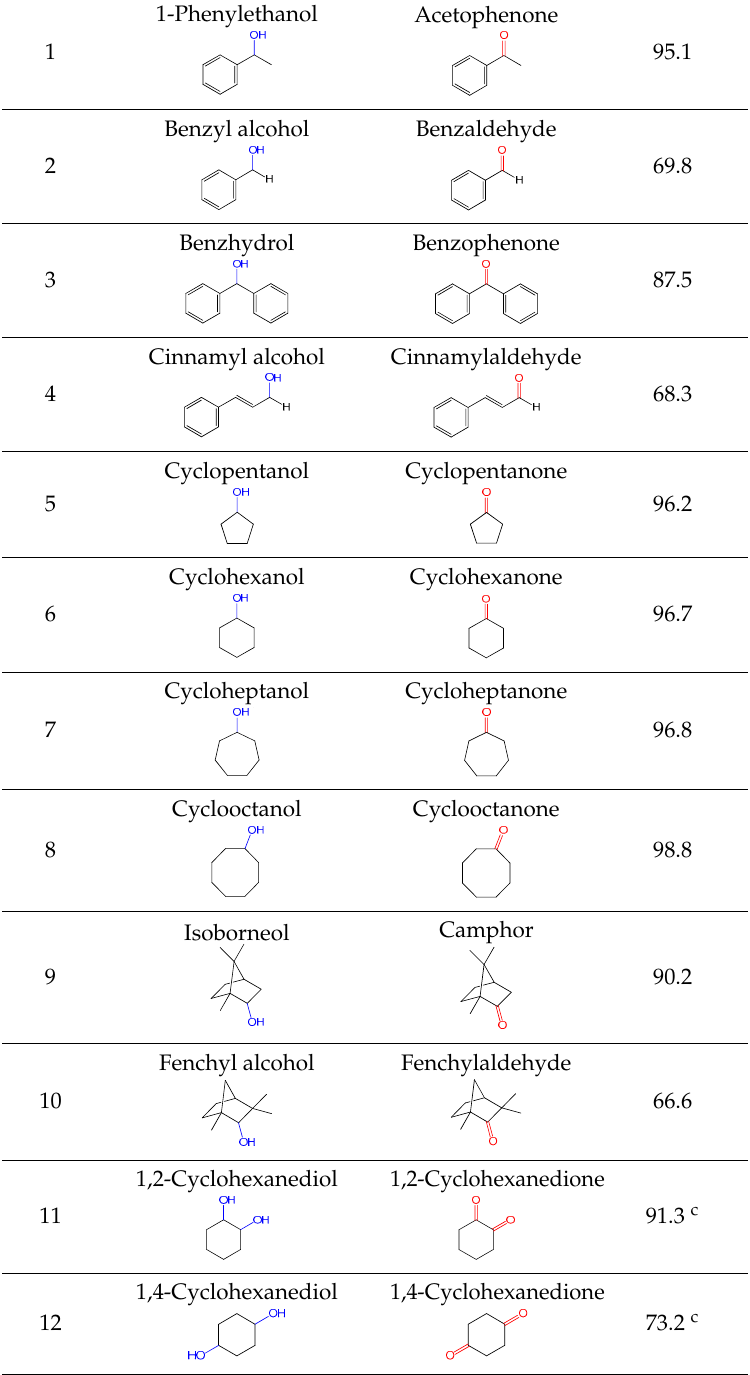
Table 2. Solvent-free MW-assisted oxidation of various alcohols using 1 MNPs as catalyst a . Table 2. Solvent ‐ free MW ‐ assisted oxidation of various alcohols using 1 MNPs as catalyst. a Table 2. Solvent ‐ free MW ‐ assisted oxidation of various alcohols using 1 MNPs as catalyst. a Table 2. Solvent ‐ free MW ‐ assisted oxidation of various alcohols using 1 MNPs as catalyst. a Table 2. Solvent ‐ free MW ‐ assisted oxidation of various alcohols using 1 MNPs as catalyst. a Table 2. Solvent ‐ free MW ‐ assisted oxidation of various alcohols using 1 MNPs as catalyst. a Table 2. Solvent ‐ free MW ‐ assisted oxidation of various alcohols using 1 MNPs as catalyst. a Table 2. Solvent ‐ free MW ‐ assisted oxidation of various alcohols using 1 MNPs as catalyst. a Table 2. Solvent ‐ free MW ‐ assisted oxidation of various alcohols using 1 MNPs as catalyst. a Table 2. Solvent ‐ free MW ‐ assisted oxidation of various alcohols using 1 MNPs as catalyst. a Table 2. Solvent ‐ free MW ‐ assisted oxidation of various alcohols using 1 MNPs as catalyst. a Table 2. Solvent ‐ free MW ‐ assisted oxidation of various alcohols using 1 MNPs as catalyst. a Table 2. Solvent ‐ free MW ‐ assisted oxidation of various alcohols using 1 MNPs as catalyst. a Table 2. Solvent ‐ free MW ‐ assisted oxidation of various alcohols using 1 MNPs as catalyst. a Table 2. Solvent ‐ free MW ‐ assisted oxidation of various alcohols using 1 MNPs as catalyst.